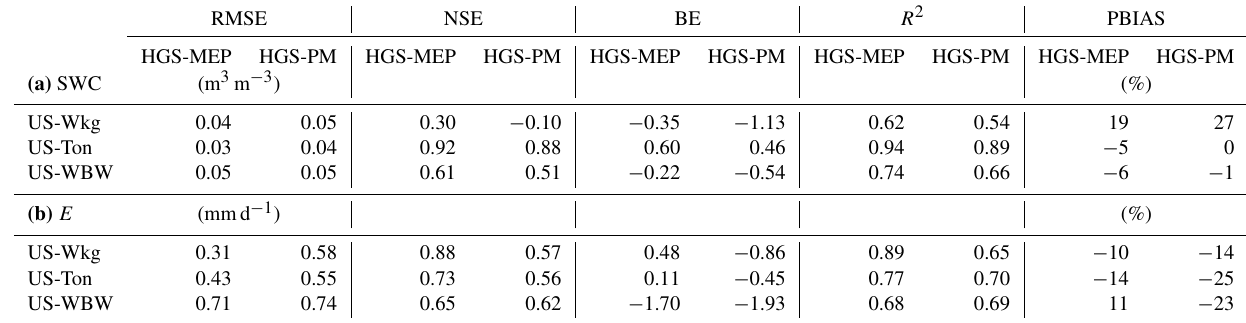
Table 4. Performance of the HGS-MEP and HGS with Penman–Monteith (HGS-PM) models when simulating (a) daily mean soil water content (SWC) at a 15 or 20cm depth and (b) daily mean total terrestrial evaporation ( E ) as represented by the root-mean-square error